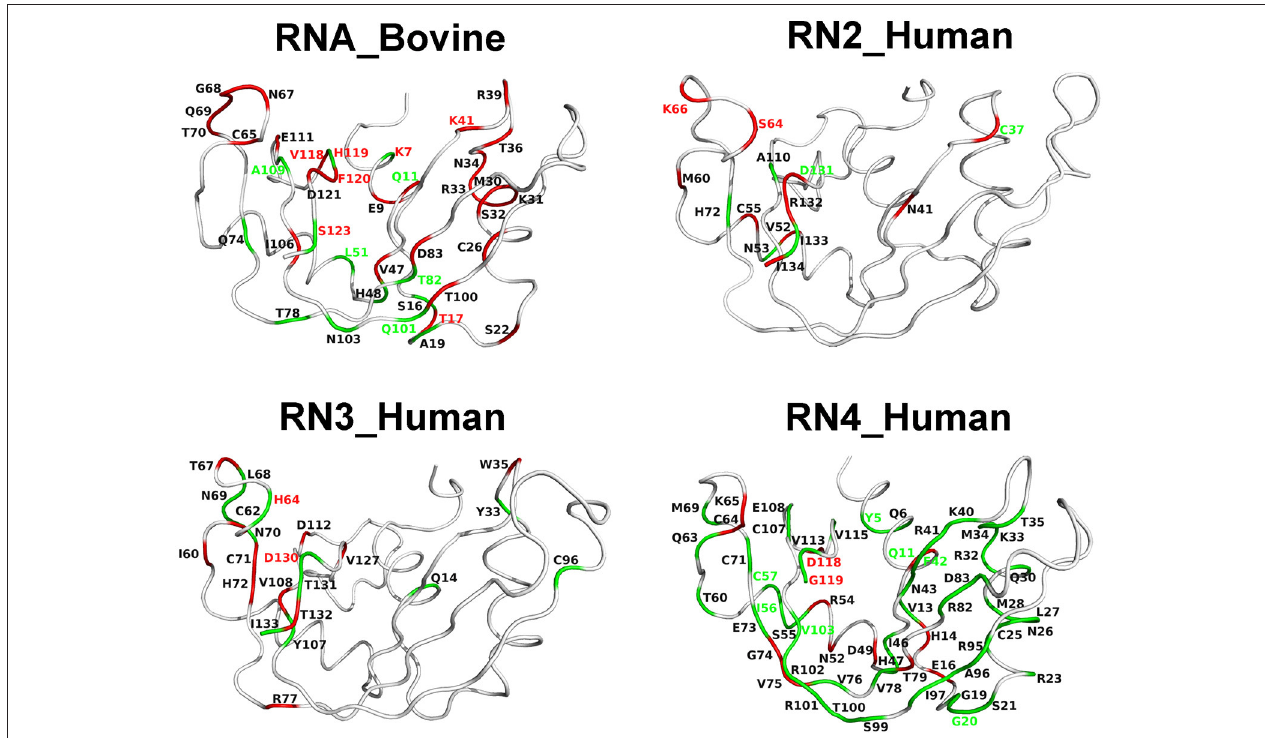
FIGURE 6 | Coordinated conformational exchange and chemical shift perturbations in functionally distinct RNases upon ligand binding. Millisecond timescale dynamics was probed using 15 N-CPMG relaxation dispersion experiments following binding of 3 ′ -UMP and 5 ′ -AMP to bovine RNase A (RNA_Bovine) and human RNases 2 (RN2_Human), 3 (RN3_Human), and 4 (RN4_Human). RNase 5 (RN5_Human) is not shown, as no measurable relaxation dispersion effects were observed upon ligand binding to this enzyme on this timescale. Residues displaying changes in conformational exchange upon binding (relative to the apo state) for both 3 ′ -UMP and 5 ′ -AMP are shown in green, while residues that show dynamical changes upon binding of only one of the two ligands are shown in red (see section Methods). Dynamical residues that also display coordinated or uncoordinated displacements in the chemical shift projection analysis ( Figure 5 ) are highlighted using green and red residue labels,